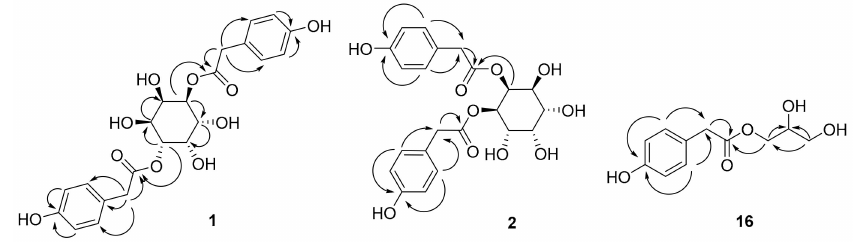
Figure 2. Key HMBC correlations of compounds 1 , 2 and 16